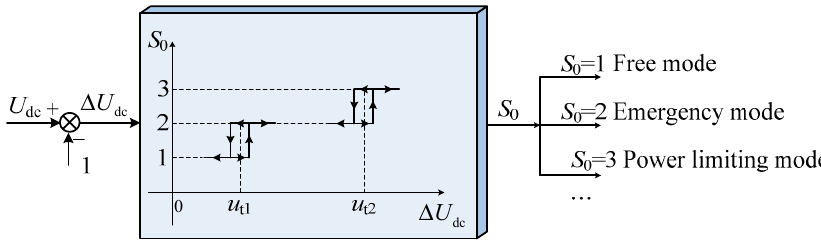
Figure 11. Operation mode judgment through voltage hysteresis.